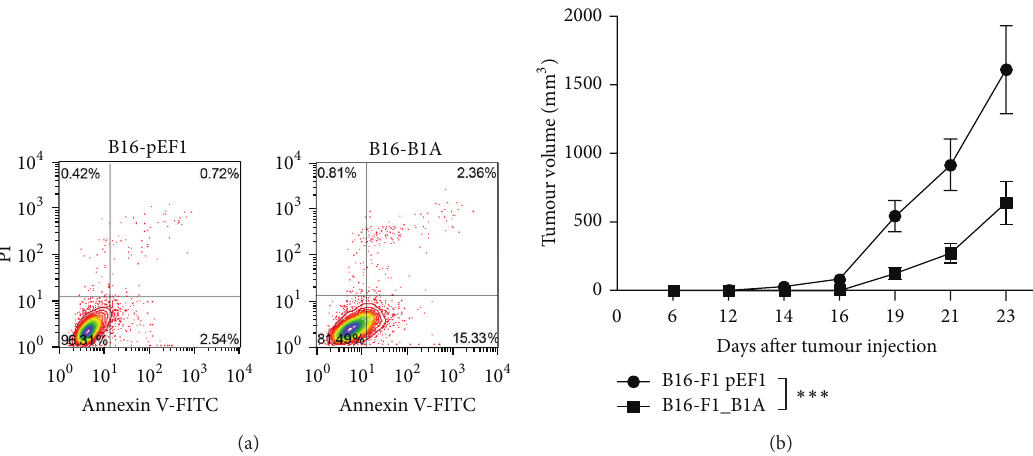
Figure 6: A-SMase expression reduces tumour growth. (a) Flow cytometry analysis of cell death of B16-pEF1 and B16-B1A cells. Apoptosis/necrosis were evaluated by the double staining with annexin V-FITC and PI. A representative dot plot for each cell clone is shown ( 𝑛 = 3 ). (b) Tumour growth analysis. BC57BL/6 mice (10 animals per group) were injected in the right flank with B16-pEF1 and B16-B1A (5 × 10 4 cells). Tumour growth was monitored by measuring tumour volume (mm 3 ) every 2-3 days. Values are expressed as mean ± SEM. ∗∗∗ 𝑃 < 0.001